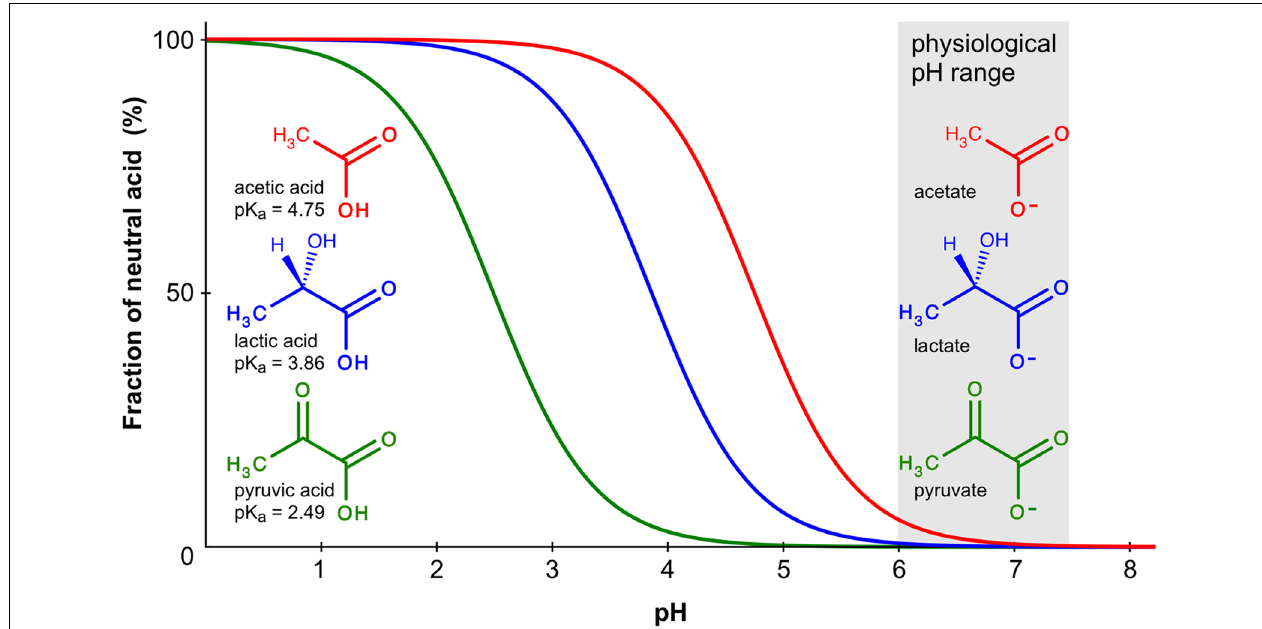
FIGURE 3 | Chemical protonation equilibrium of weak monoacids. The curves indicate the fraction of the protonated, neutral forms of acetic, lactic, and pyruvic acid in a pH range from 0 to 8. Calculations were done using the Hendersen–Hasselbalch equation; p K a values are given at the molecule structures.